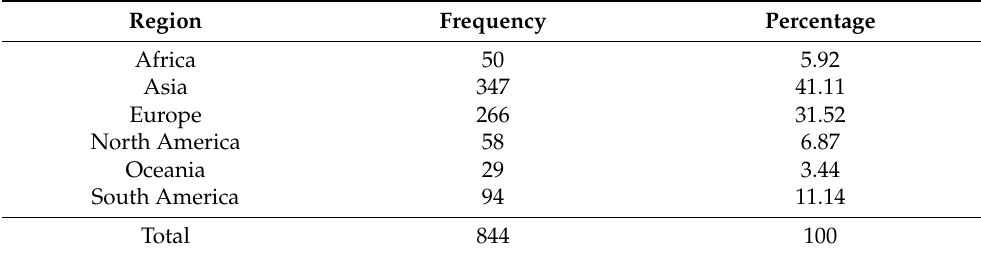
Table 2. Sample composition by